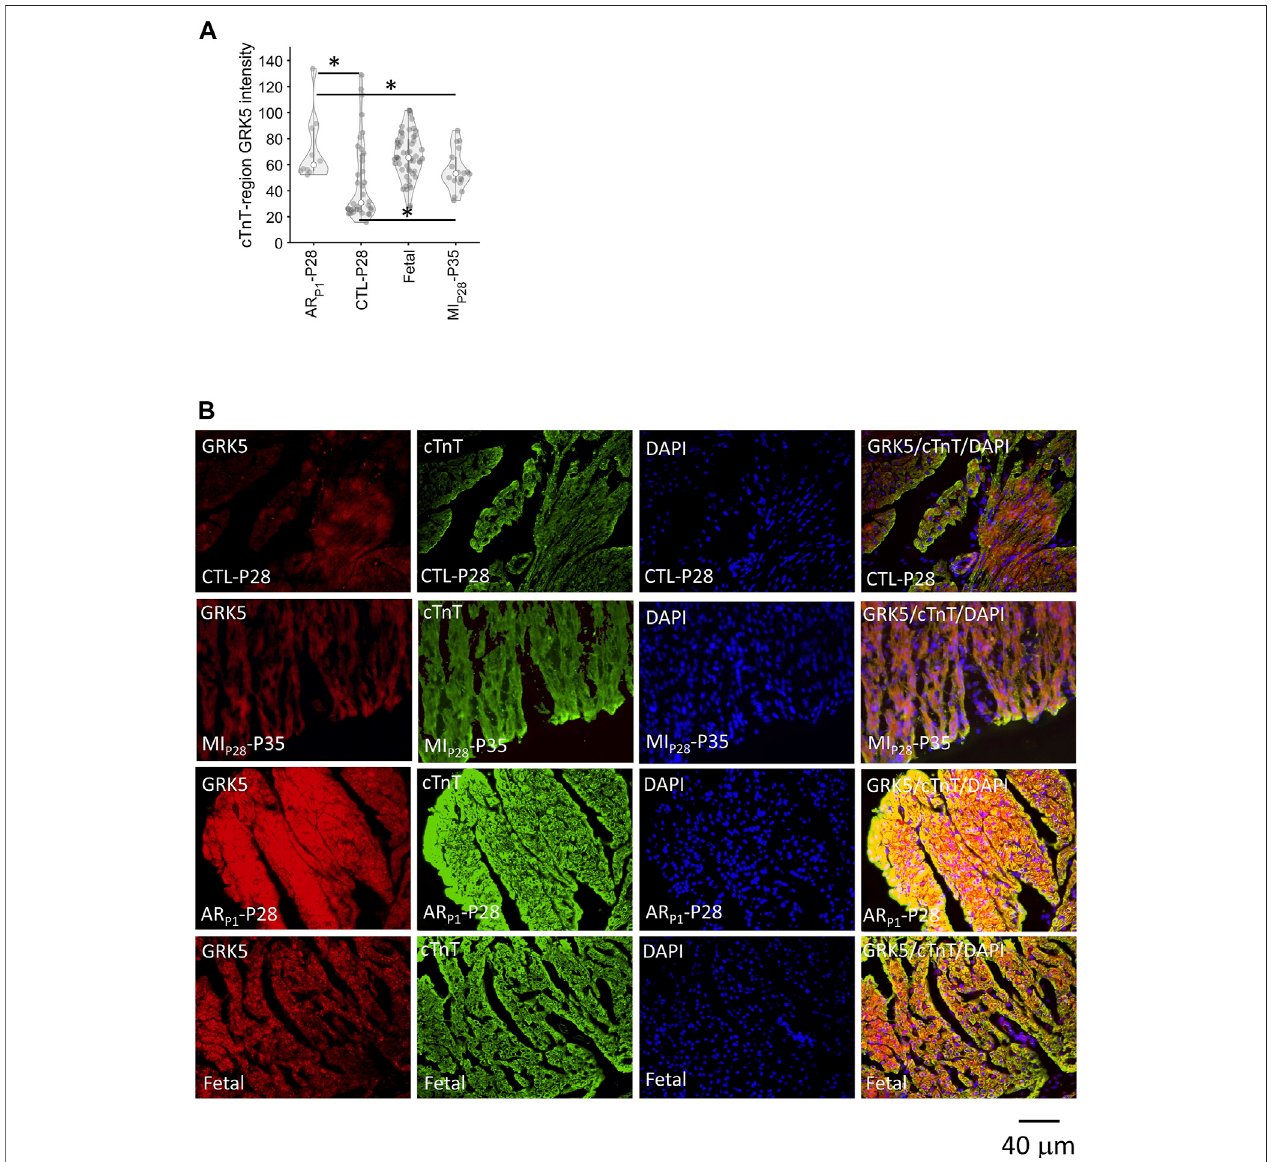
FIGURE 7 | Immuno fl uorescence analysis con fi rming GRK5 expression in cardiomyocytes. Here, the expression of GRK5 was represented by the average GRK5 red-channel value (light intensity) that is overlapped with cardiac troponin (cTnT) blue-channel (foreground), which was calculated after adjusting GRK5 red- channel background. DAPI (blue) indicates nuclei. (A) Violinplot of GRK5 intensity in 118 staining images. Here, the horizontal bar and the star (*) indicate nonparametric Wilcoxon ’ s rank sum test between two sample groups. * p -value < 0.05. (B) Representative images of GRK5/cTnT/DAPI in each group.